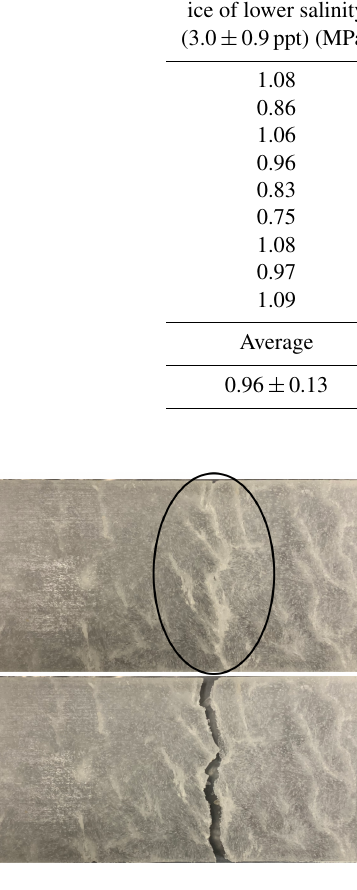
Figure 4. Photograph of a sample from the bottom of an ice block of higher salinity (5.9 ± 0.6ppt) before cycling (a) and after (b) fail- ure. Note a crack that propagated along whitish features in the area in (a) depicted by the circle. Scale bars: